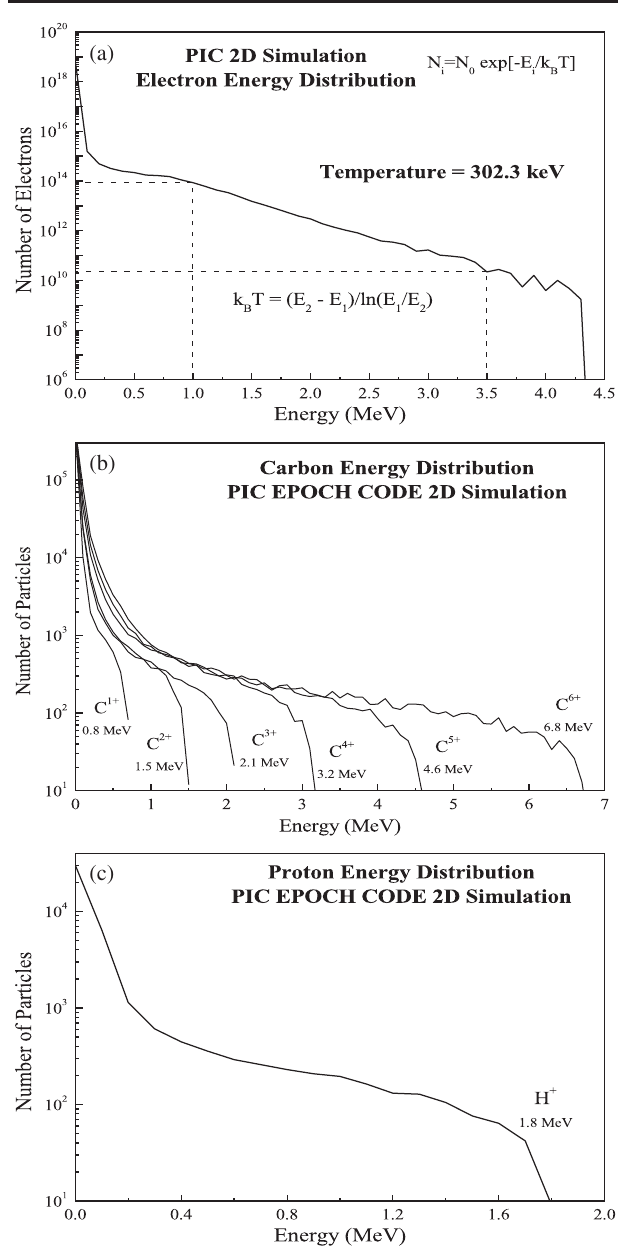
FIG. 7. Electrons energy spectrum and plasma temperature evaluation (a), number of carbon ions versus energy by charge state (b), and number of protons versus energy (c), calculated from PIC